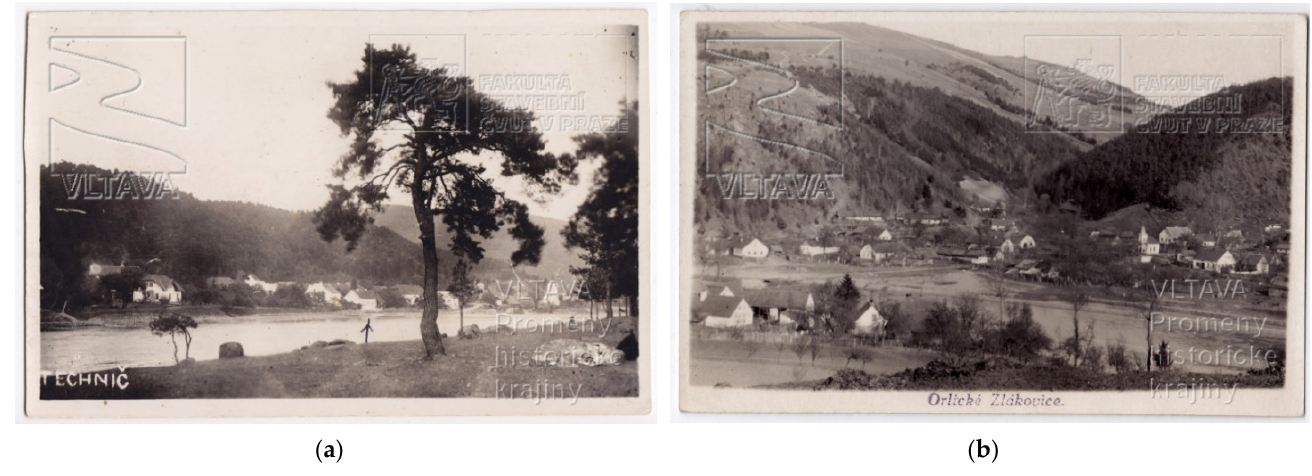
Figure 9. ( a ) T ě chce as seen from the pine grove on the right bank, 1930s, photo Plichta Pe č ice, period Figure 9. ( a ) Tˇechce as seen from the pine grove on the right bank, 1930s, photo Plichta Peˇcice, period postcard, archive of Vojt ě ch Pavel č ík, ( b ) Overall view of Orlice Zlákovice from the hillside on the postcard, archive of Vojtˇech Pavelˇc í k, ( b ) Overall view of Orlice Zl á kovice from the hillside on the left left bank, 1930s, photo by Plichta Pe č ice, period postcard, archive of Vojt ě ch Pavel č ík. bank, 1930s, photo by Plichta Peˇcice, period postcard, archive of Vojtˇech Pavelˇc í